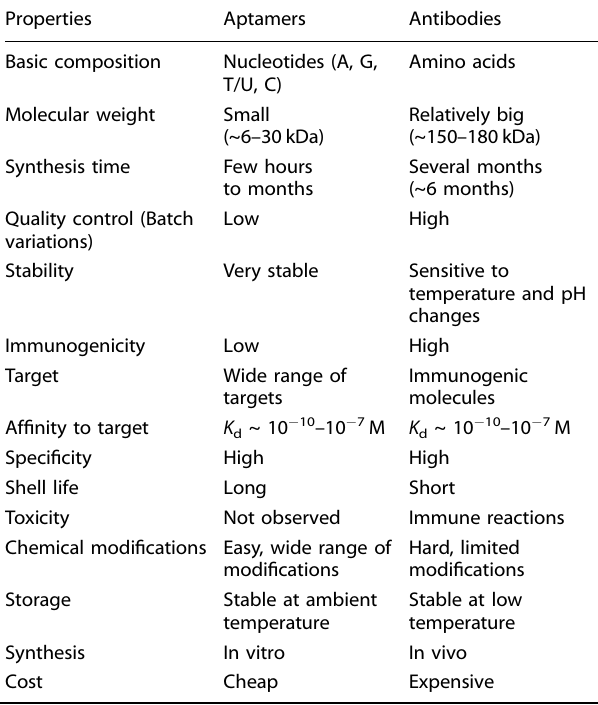
Table 1. Aptamers as an alternative to antibodies: